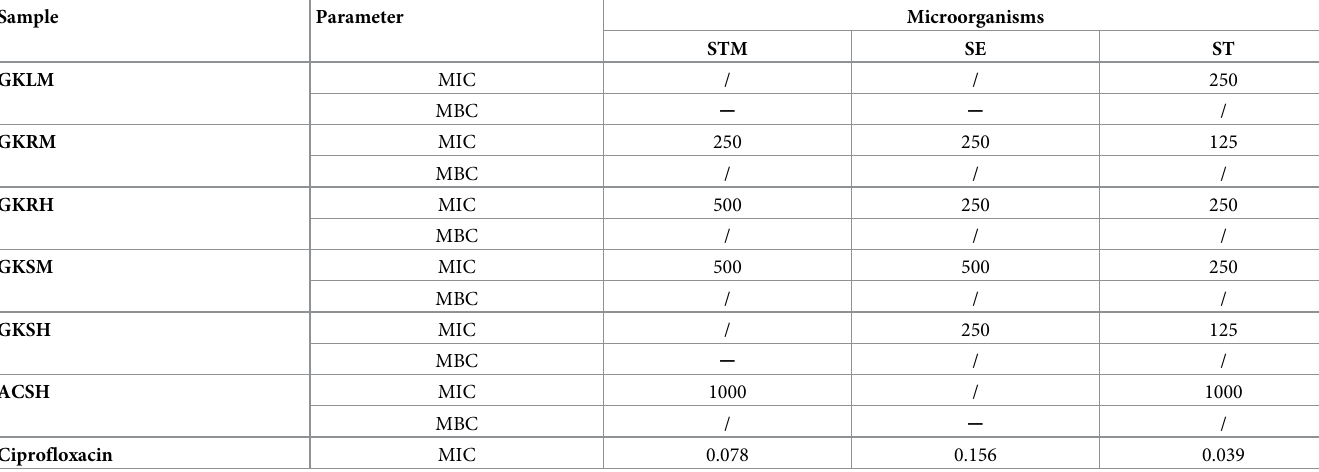
Table 1. Minimum inhibitory (MIC) and bactericidal (MBC) concentrations ( μ g/mL) of the methanolic and hydro-ethanolic extracts of G . kola and A . Cordifolia .